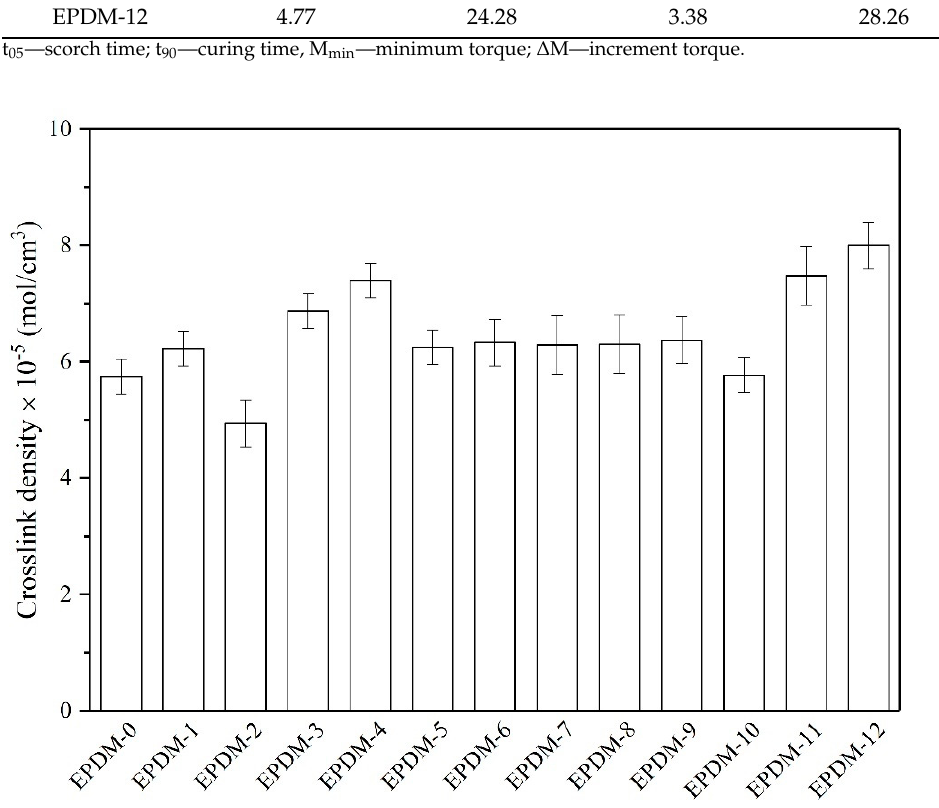
Figure 7. Crosslink density values of EPDM-filled composites.